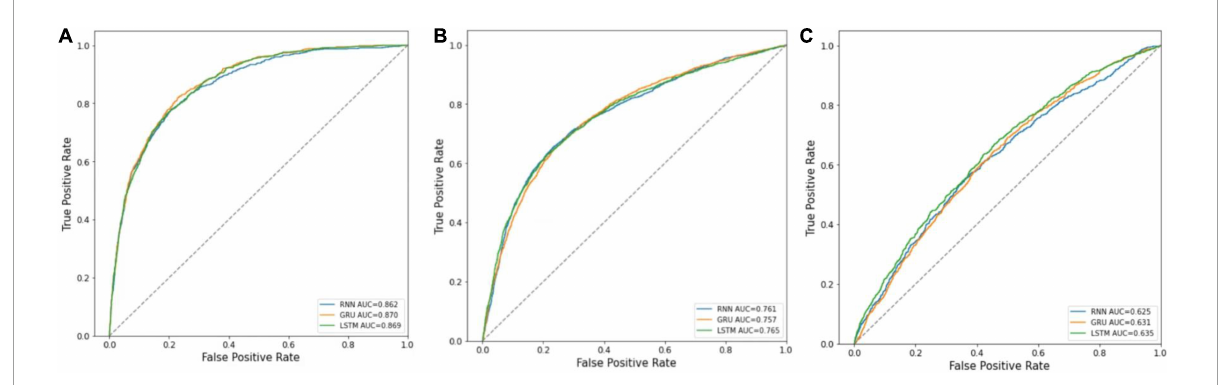
FIGURE3 ROC curves of RNN, GRU, and LSTM. (A) Mortality prediction; (B) prolonged LOS prediction; (C) 30-day readmission prediction.